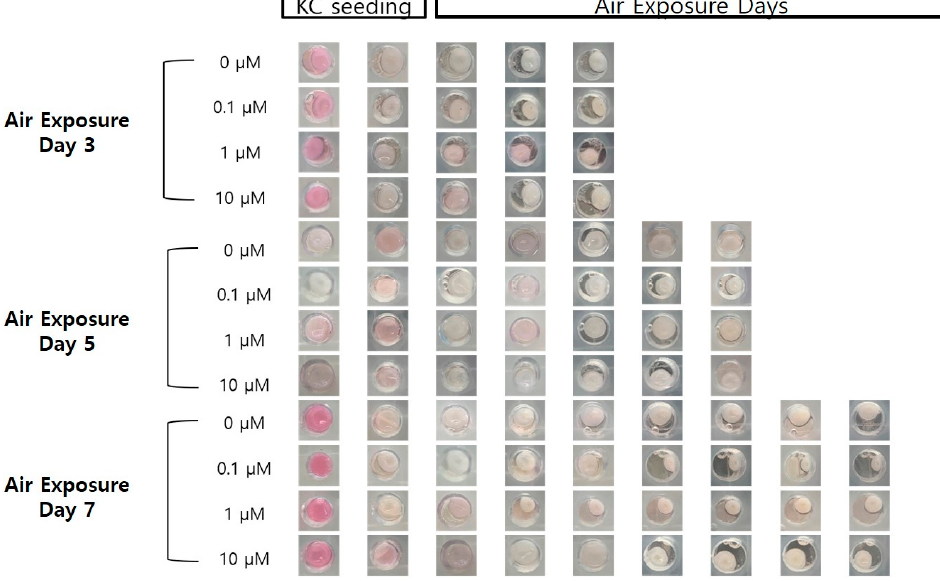
Figure 2. Photographic images of the samples, following air exposure, for the different concentrations of coenzyme Q10 (bar = 8 mm).